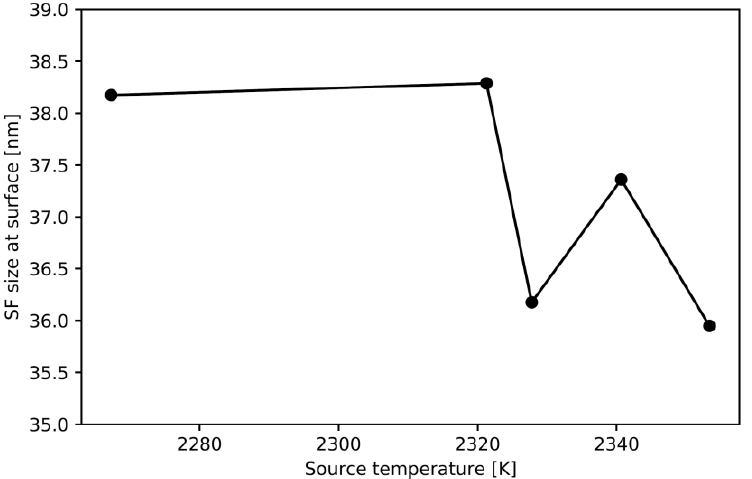
Figure 10. Average intersection length of the SF at the (100) surface as a function of the PVD growth conditions. For all the cases, growths of ≈ 50 nm-thick layers are considered.